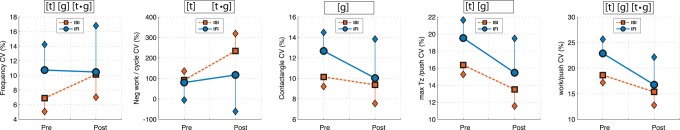
Effect of 80-minute practice on the intra-individual variability of the propulsion technique parameters (mean and standard-error of multi-level model) for the initially slow learners and the initially fast learners between the pre- and posttest.The frequency, contact angle, maximum torque per push and work per push showed an interaction effect for the groups over time. [t] = effect of time, [g] = effect of group, [t⋅g] = interaction effect of time with group.